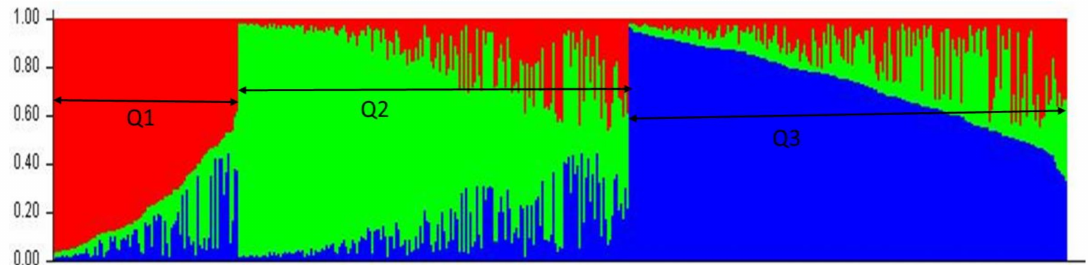
Figure5. Estimatedpopulationstructureofthe465springwheatgenotypes(K = 3)basedontheQmatrix using the single nucleotide polymorphism (SNP) markers. Q: three (K = 3) di ff erent subpopulations as Q1, Q2 and